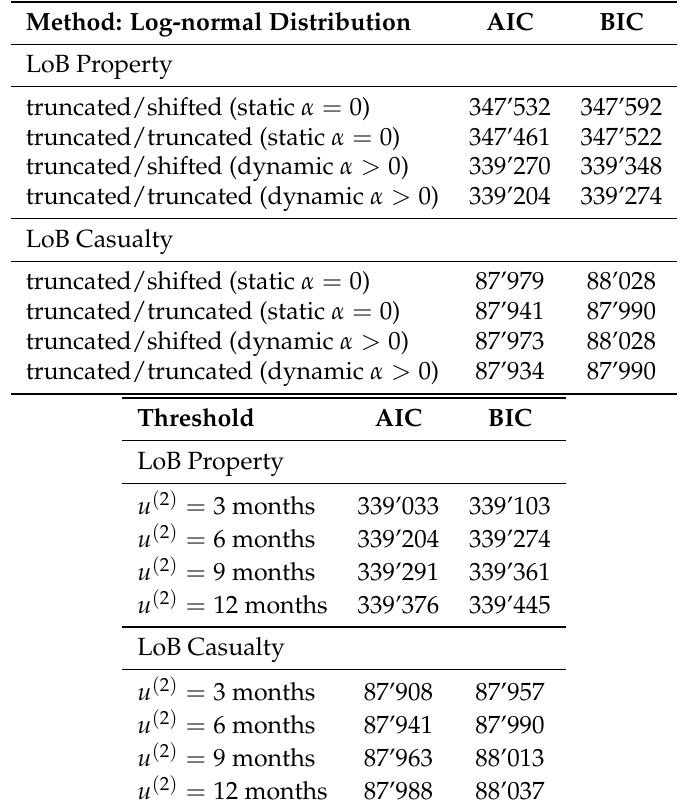
Table 5. AIC and BIC as of 31/10/2010 (top) γ = 1/4 and u ( 2 ) = 6 months and (bottom) LoB Property truncated/truncated dynamic ( α > 0) log-normal model with γ = 1/4 and LoB Casualty truncated/truncated static ( α = 0) log-normal